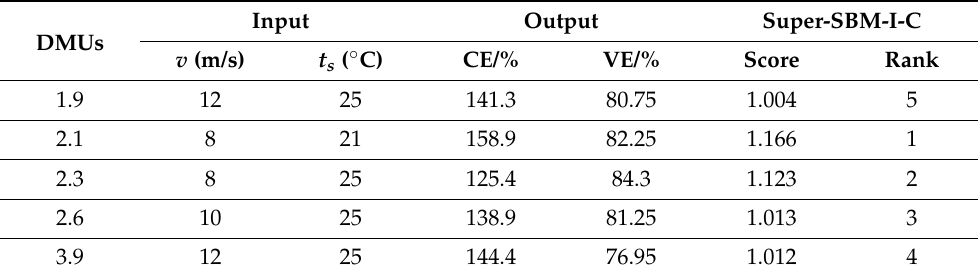
Table 9. Evaluation ranking of 5 top DMUs using Super-SBM-I-C